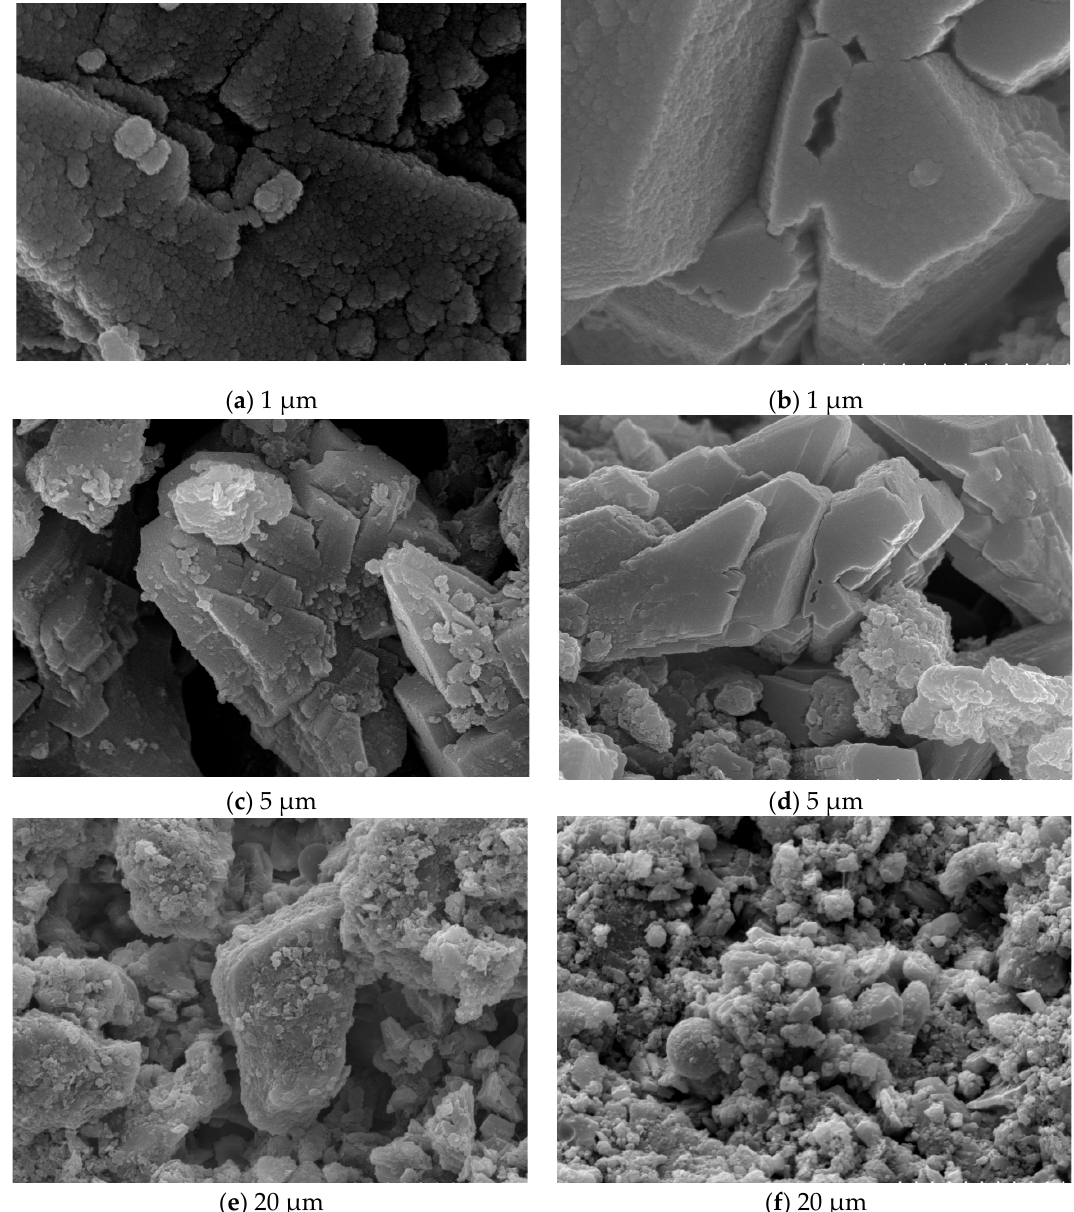
Figure 4. Surface image of CWs ( a , c , e ) UCWTR and ( b , d , f ) clay ceramsite.